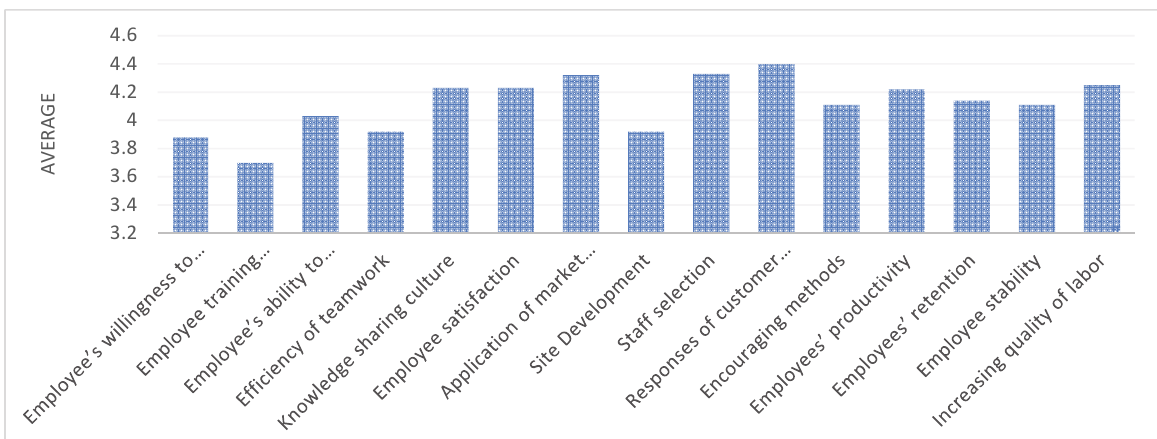
Fig. 8. Indicators of internal process construct and their averages